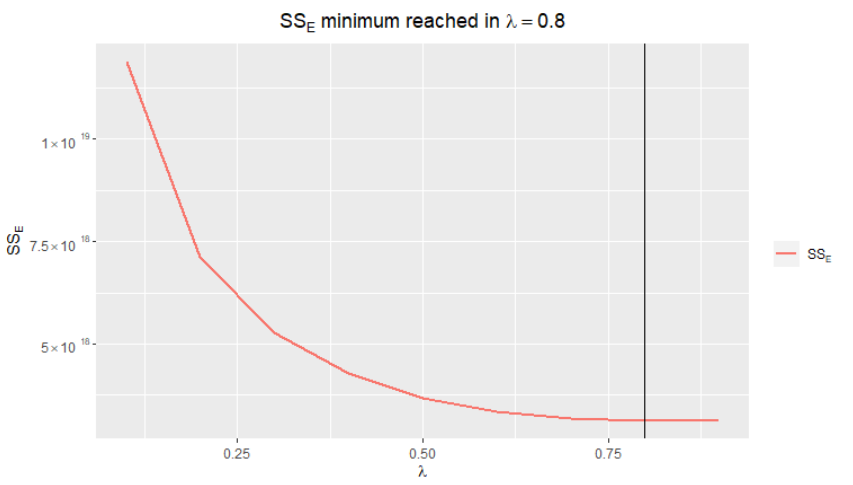
Figure 4. SS E plot for different values of λ .